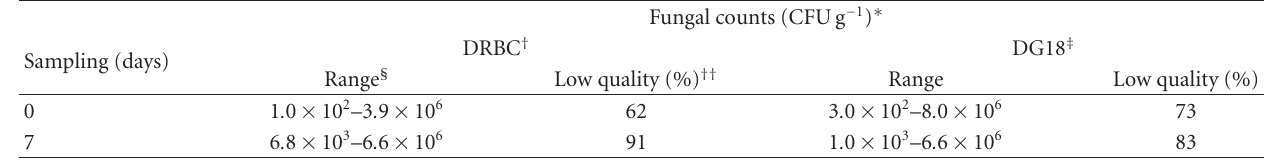
Table 2: Fungal counts (CFUg − 1 ) in DRBC and DG18 media from brewer’s samples.